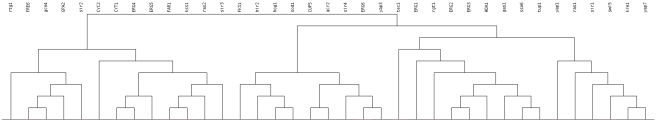
Clustering of yeast samples with PEFs using Pearson's correlation.Sample tree originated from the clustering of FET Pathway Enrichment Factors (PEFs) values with Pearson's correlation.